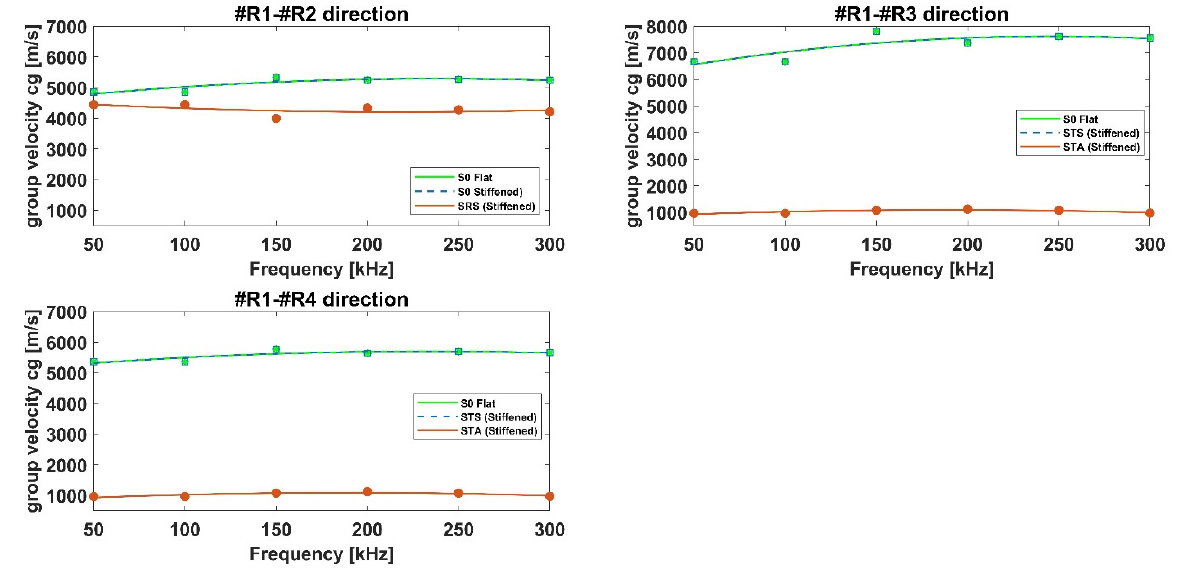
Figure 16. Comparison of the group velocities of the incident and converted/reflected S 0 modes detected in the flat and reinforced configurations – composite panels.